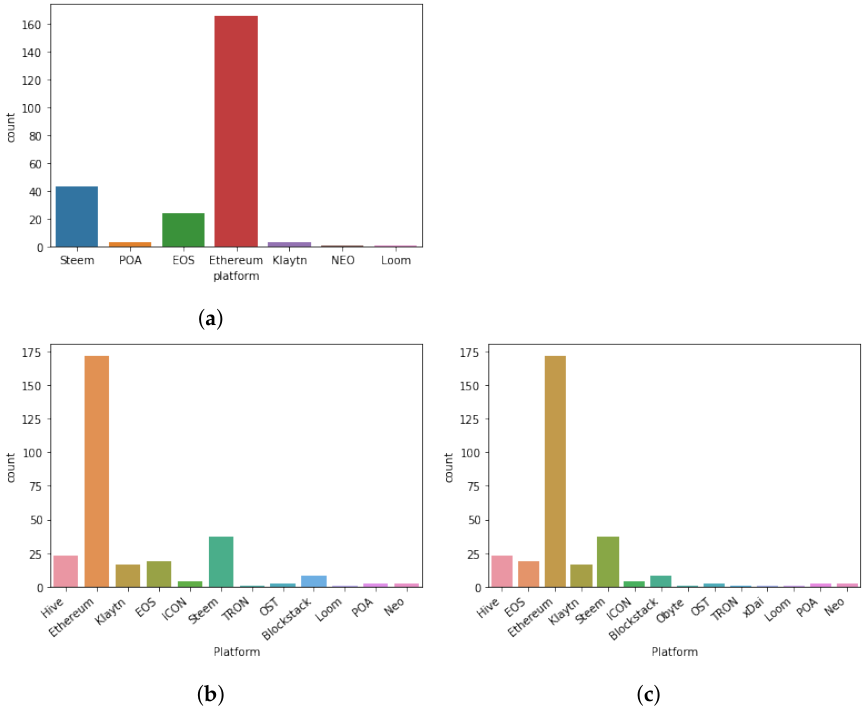
Figure 2. Blockchain used by DApps considering the social category. (information collected the 14th of May, 2021) ( a ) Overview of the Social DApps (2019); ( b ) Overview of the Social DApps (2020); ( c ) Overview of the Social DApps